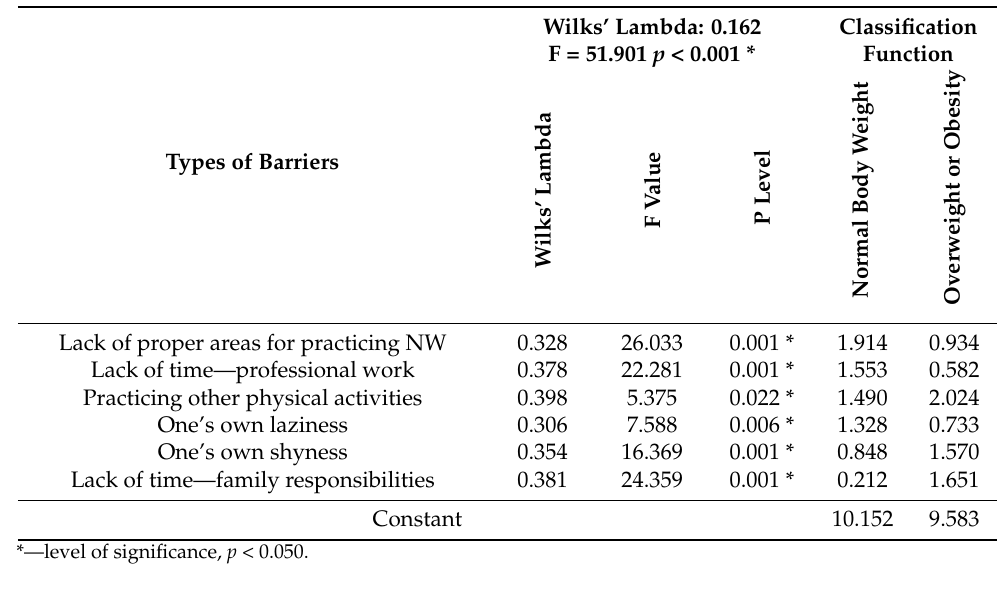
Table 5. Barriers affecting participation in NW